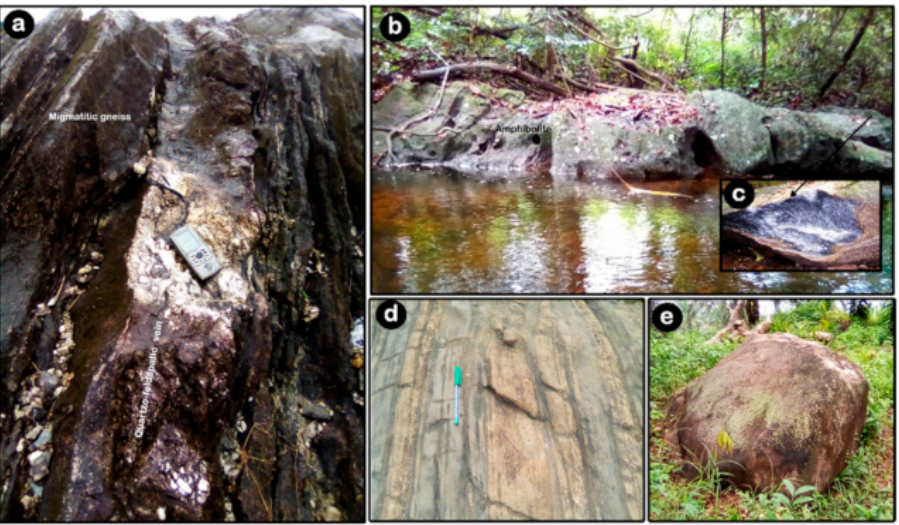
Figure 5. Rock exposures in the study area (Oban Massif): ( a ) Migmatitic gneiss at Oban town, ( b ) Ho- mogeneous amphibolite exposed at the bank of River Ajin, ( c ) a broken fragment exposing the fresh surface of amphibolite, ( d ) low-lying banded gneiss exposed in Okarara showing disproportionate mineral segregation of light and dark bands (ball pen in the direction of North), and ( e ) large boulder of granitic rock exposed near Okarara.